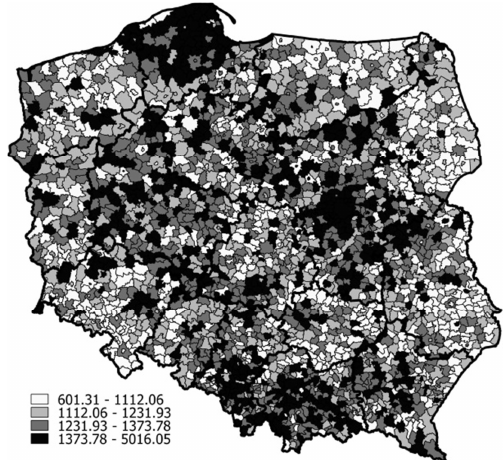
Source: created by the authors based on CSO data. Figure 2. Local share of education funding per capita in 2016 (by quartiles)